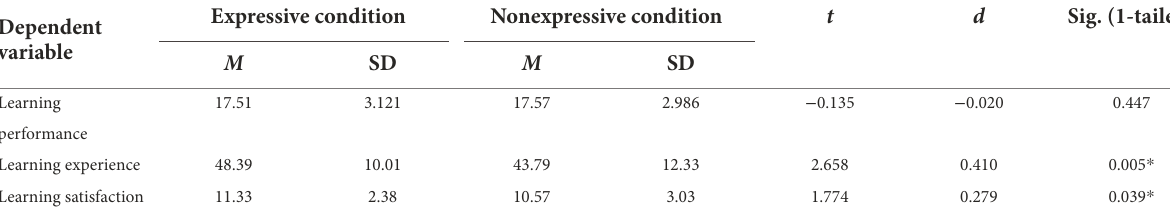
TABLE 4 The descriptive statistics for dependent variables in experiment